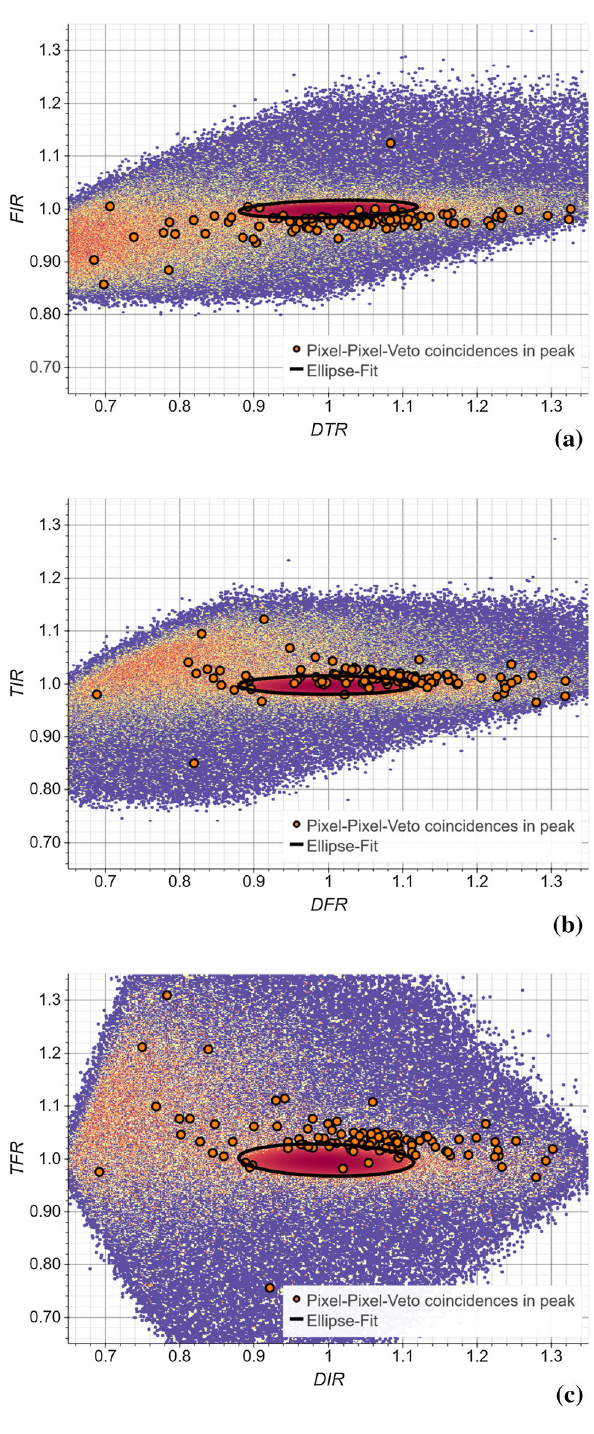
Fig. 18 The three useful parameter spaces. The ellipses are nearly not tilted and the minor/major axes have nearly similar